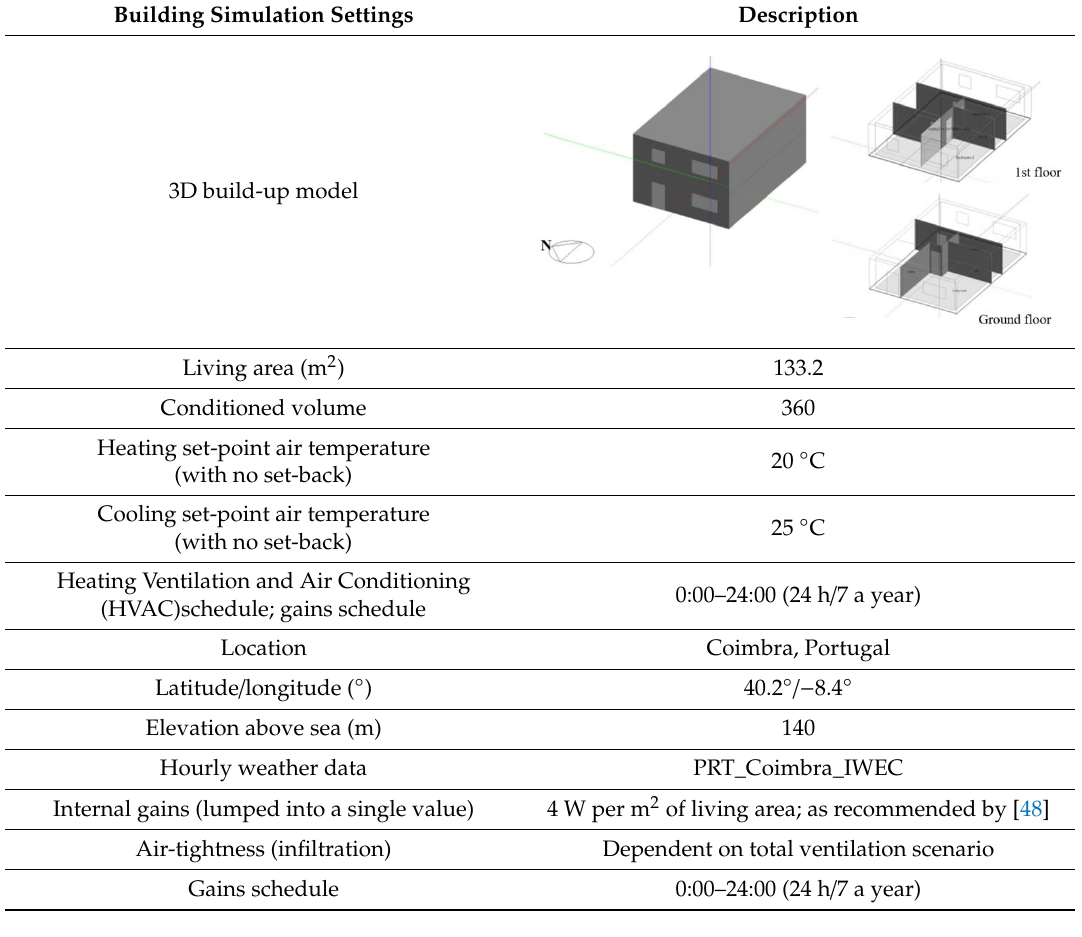
Table 5. Window shading schedule.